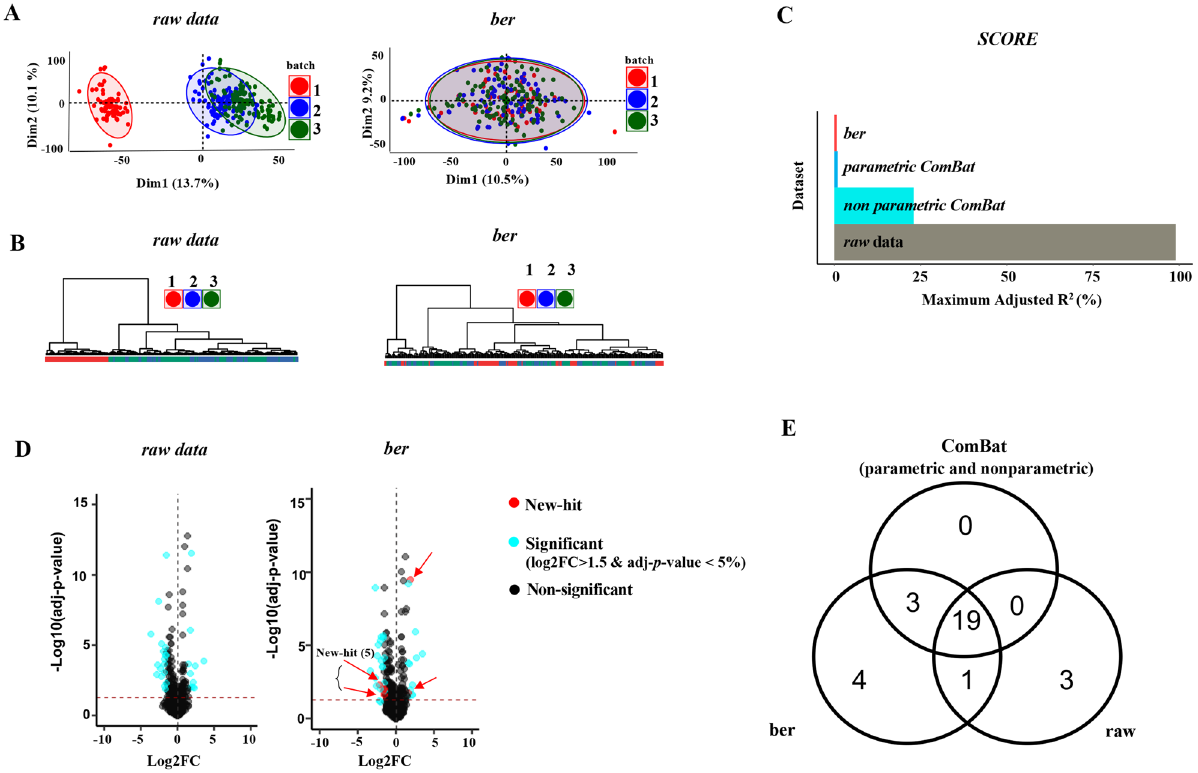
Figure 4. Monitoring of batch effect in LC–MS untargeted metabolomics and its correction with “dbnorm” . ( A ) PCA plots of mouse fat tissue metabolome acquired for 264 samples in negative polarity showed sample separation associated with the experimental runs in raw data and its correction upon correction using ber . ( B ) Dendrogram of raw data confirmed clustering of samples linked to batch number, particularly for batch 1. Upon correction using ber -function, data points overlapped without any distinct batch driven grouping of samples in dendrograms. The color code indicates the batch number. ( C ) The score plot represents the maximal absolute adj-R 2 as estimated in raw data and in ber -, nonparametrice ComBat- , and parametric ComBat -corrected data. ( D ) Volcano plots of raw and ber -corrected data demonstrates the impact of HFD on the list of metabolites whose level significantly changes in response to the treatment. The metabolites appearing as significantly regulated only in ber -corrected data are depicted as red dots and arrows. Significant criteria of Log2FC > 1.5 and adj- p -value < 0.05 are considered to draw a list of metabolites with differential level. ( E ) Venn diagram showing the number of metabolites significantly altered by 8 weeks of HFD in sc-AT metabolome before and after batch correction through statistical models ( ber , par ametric and nonparametric ComBat). Correction with either parametric or nonparametric ComBat results in the same list of differentially expressed